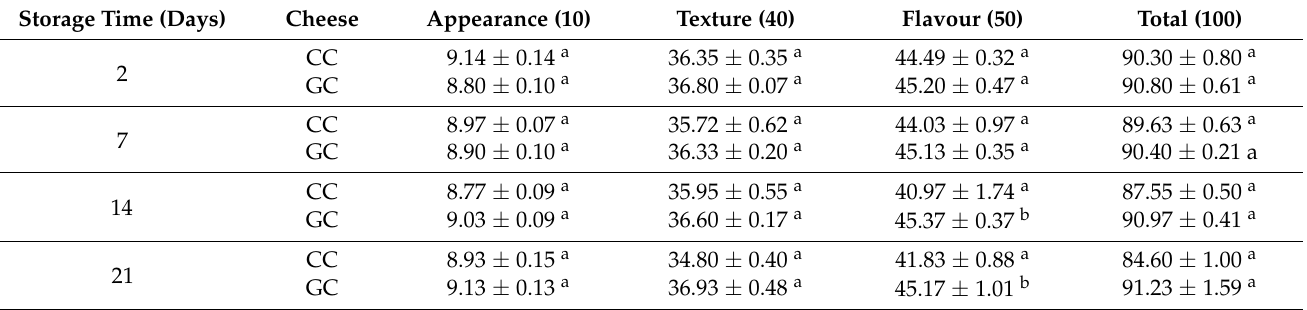
Table 3. Organoleptic characteristics of GC and CC fresh spreadable cheeses made from ovine milk. Storage Time (Days)